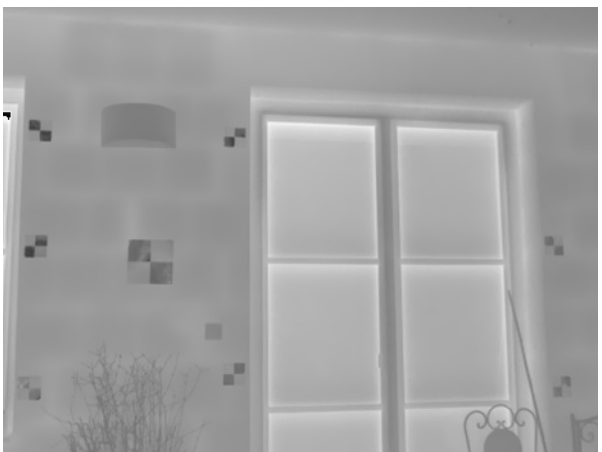
Figure 4. Image captured from 4 m distance. In the image are recognizable cross aluminum paper targets. Table 3. Approximate sample distances for images captured from different distances.